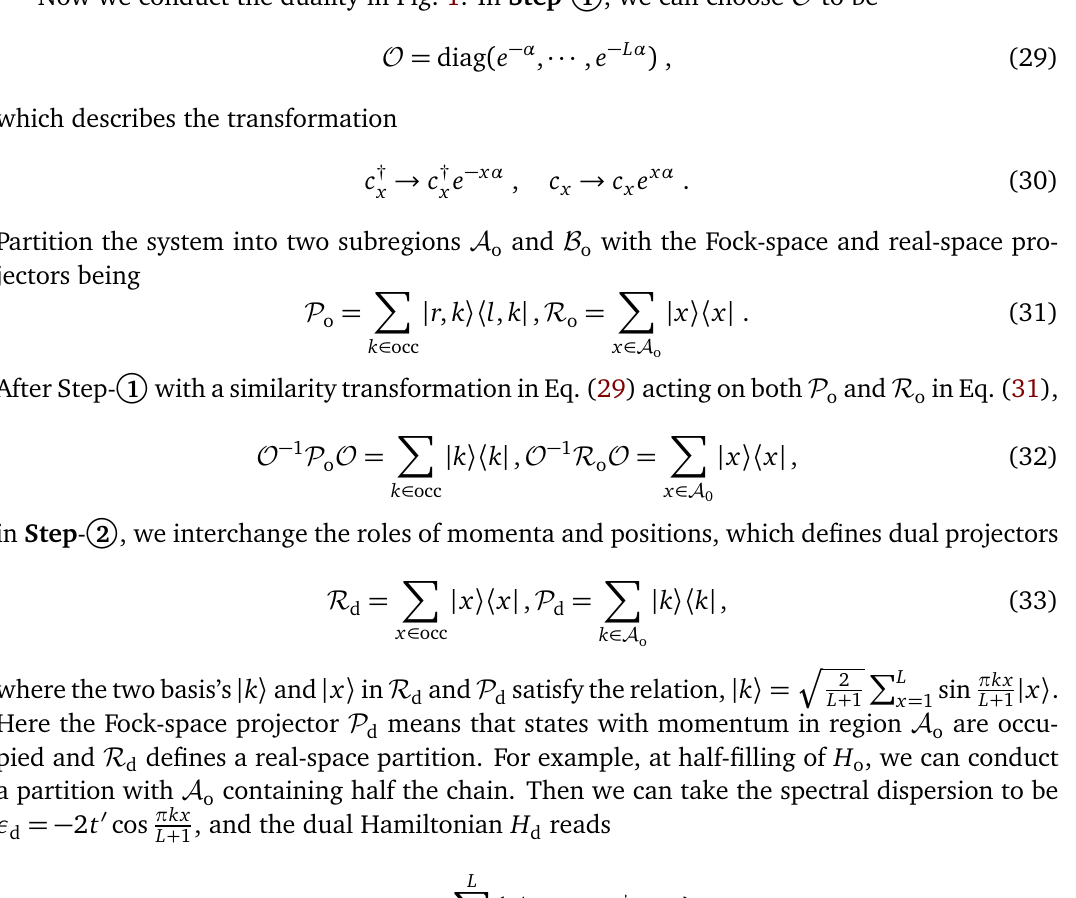
Figure 2: Illustration of non-reciprocal model and its dual system for a general fill- ing and partition. After duality, the partition is changed from X = ∪ X . Non-Hermiticity in H d A d B d the dual system is Hermitian with hopping integral t (cid:48)